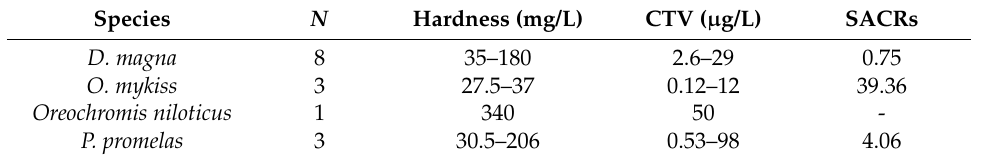
Table 2. The CTV of silver for freshwater aquatic organisms in China, and the SACRs for silver.